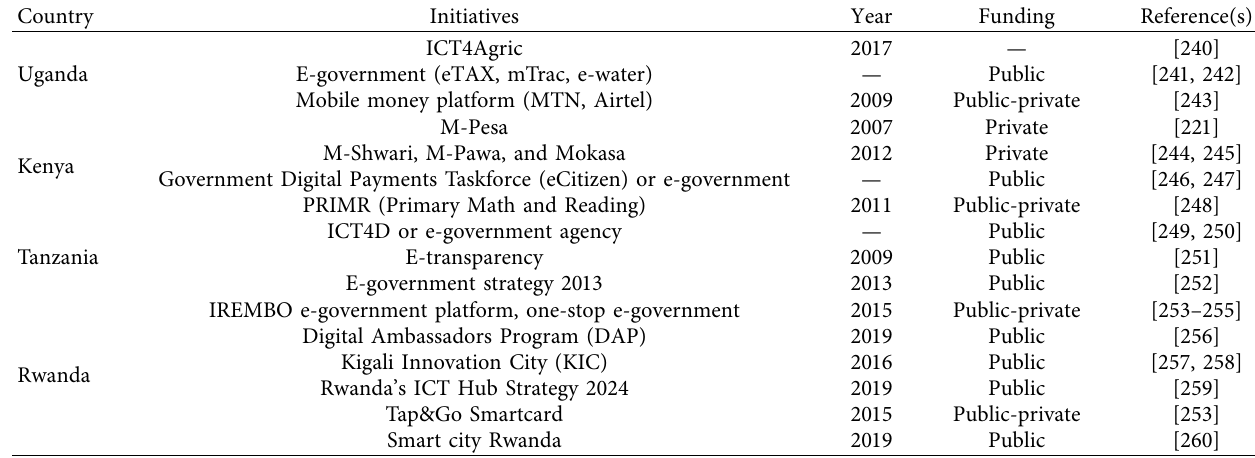
Table 11: Initiatives in the EAC launched within the ICT policies.